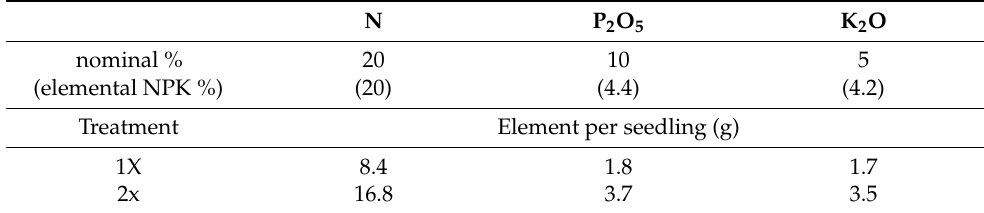
Table 2. Fertilizer treatments applied in the Rota trial.